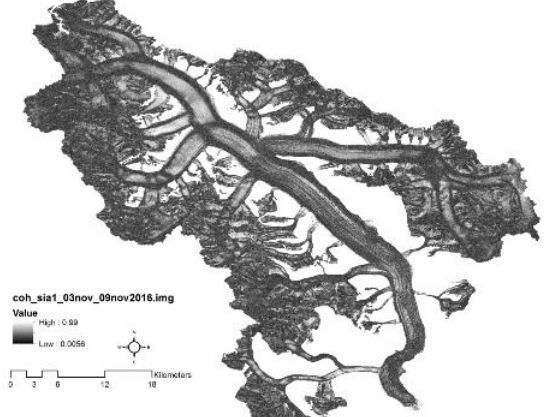
Figure 8: Coherence map of Siachen glacier